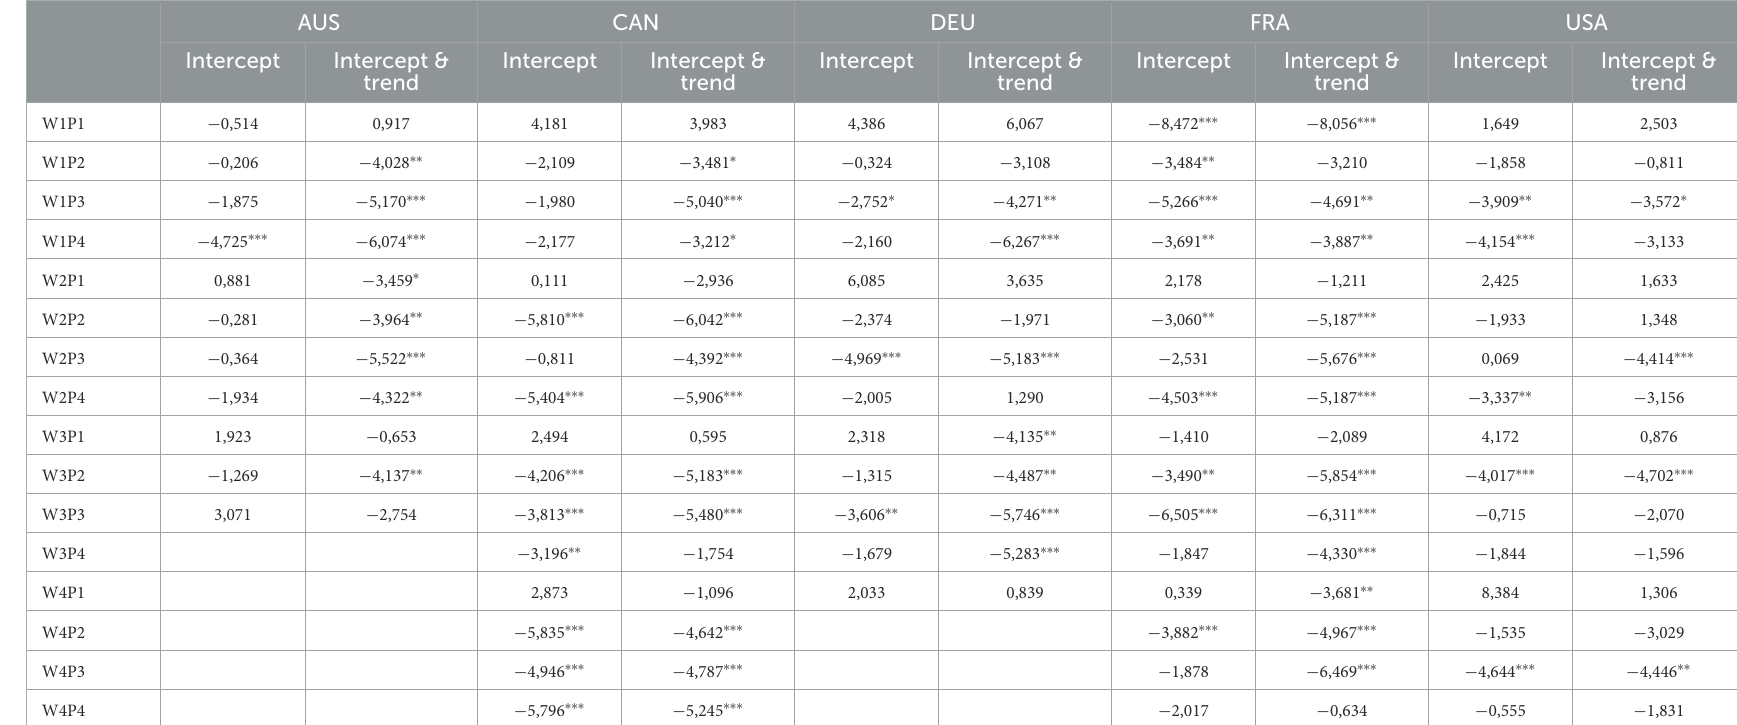
TABLE 3 The unit root test results showing the efficiency of health